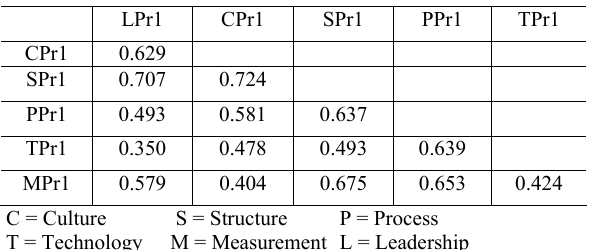
Table 2: Correlation of the principal components (Pr1) of the six main